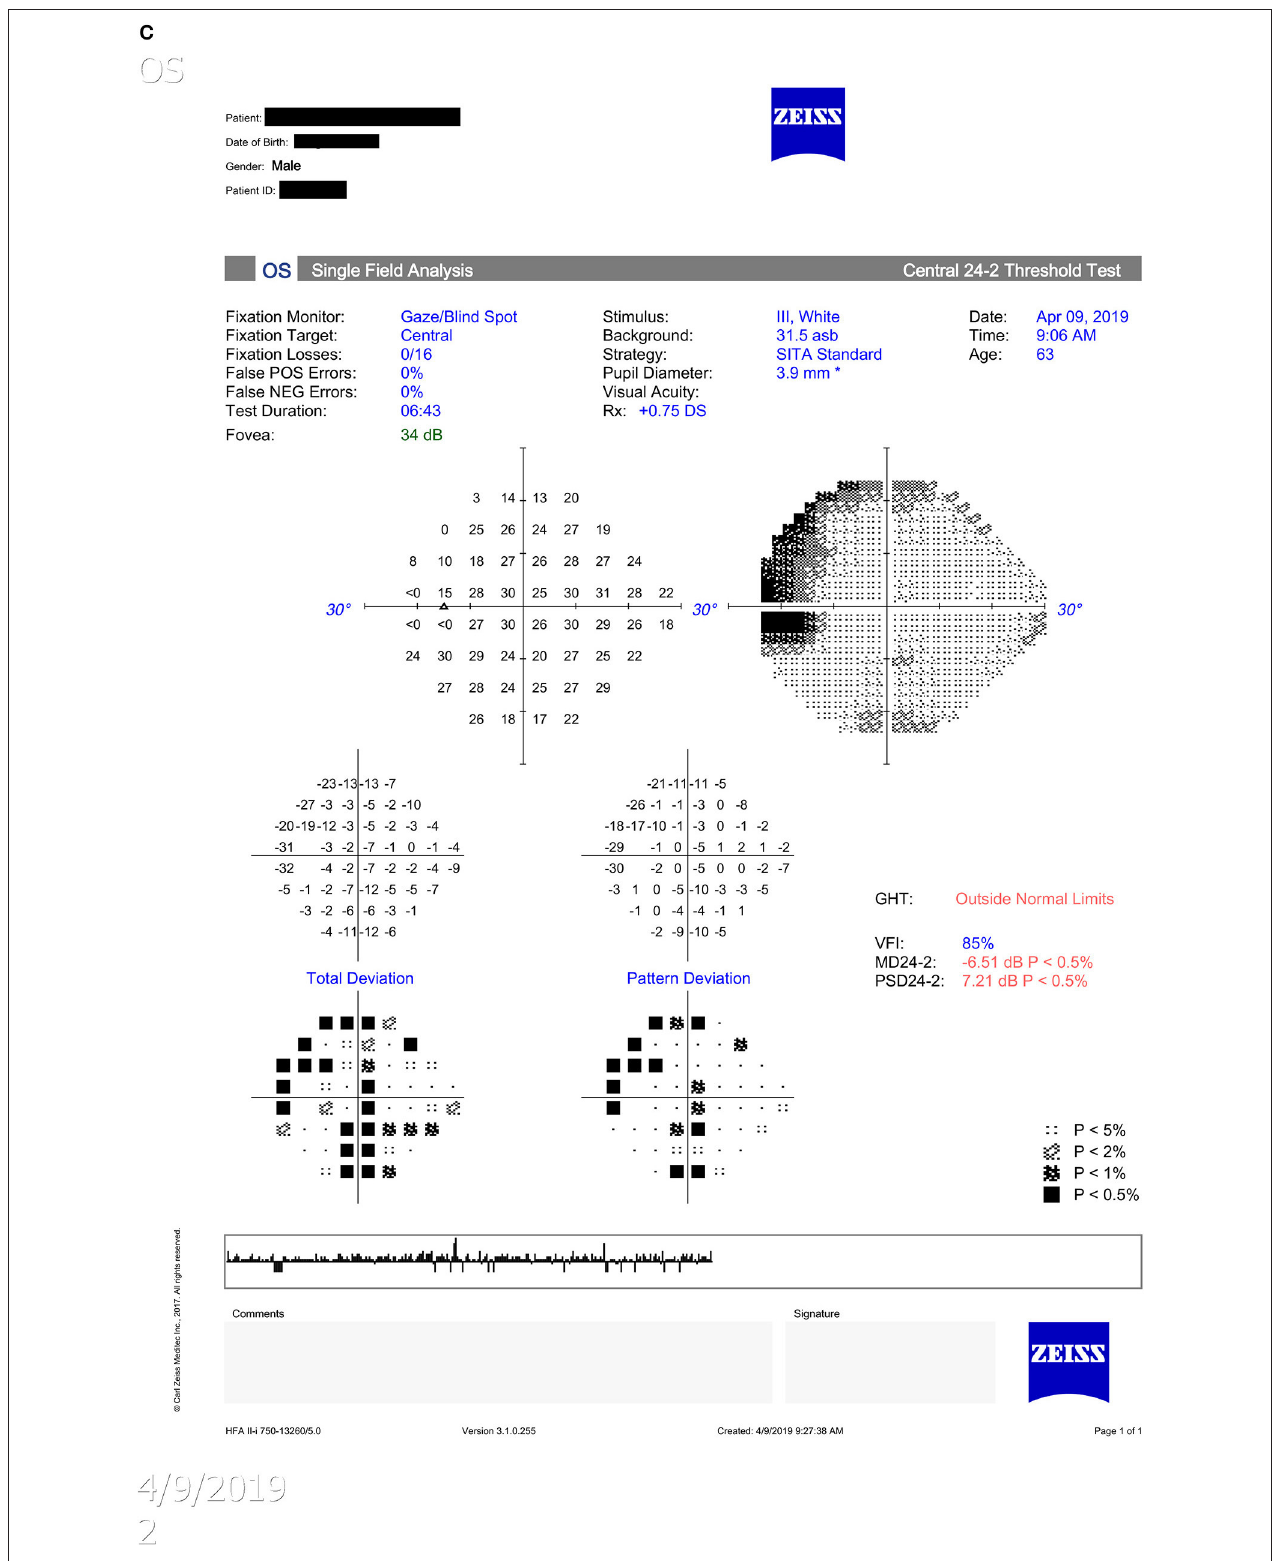
FIGURE 3 | Humphrey Visual Field report layout types. (A) Version 1 layout. (B) Version 2 layout. (C) Version 3 layout.